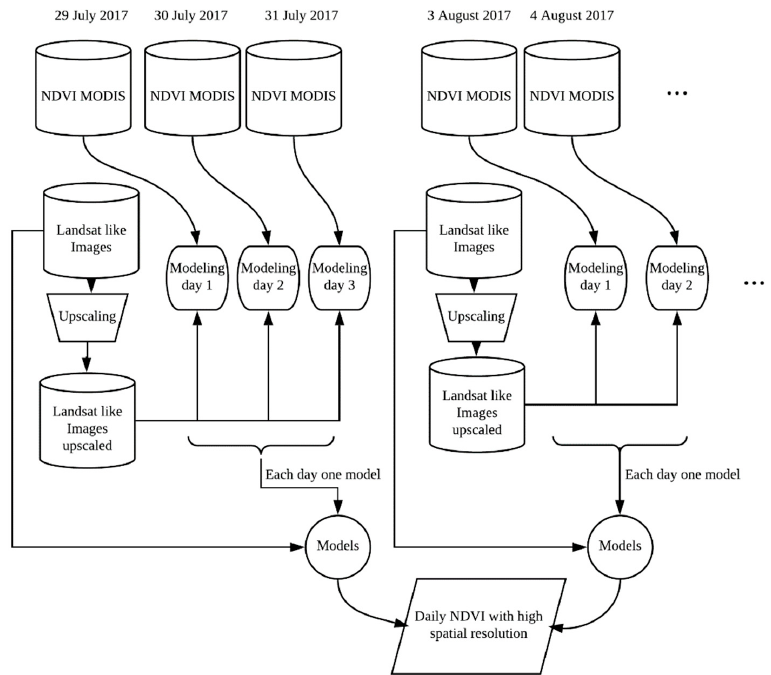
Figure 4. Processing and generation of NDVI models with a daily frequency and detailed spatial resolution, for 5 days, to exemplify the 12 days of analysis.